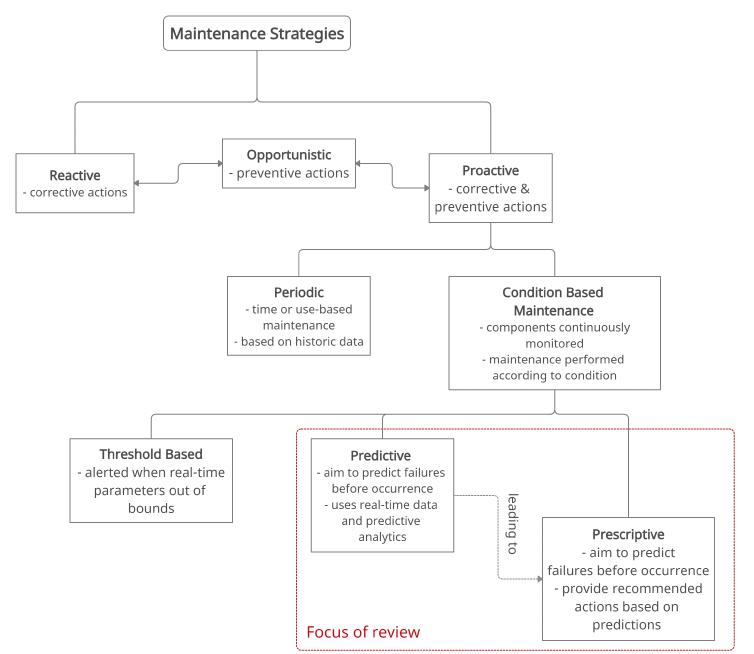
Figure 2. Categorisation of maintenance strategies.